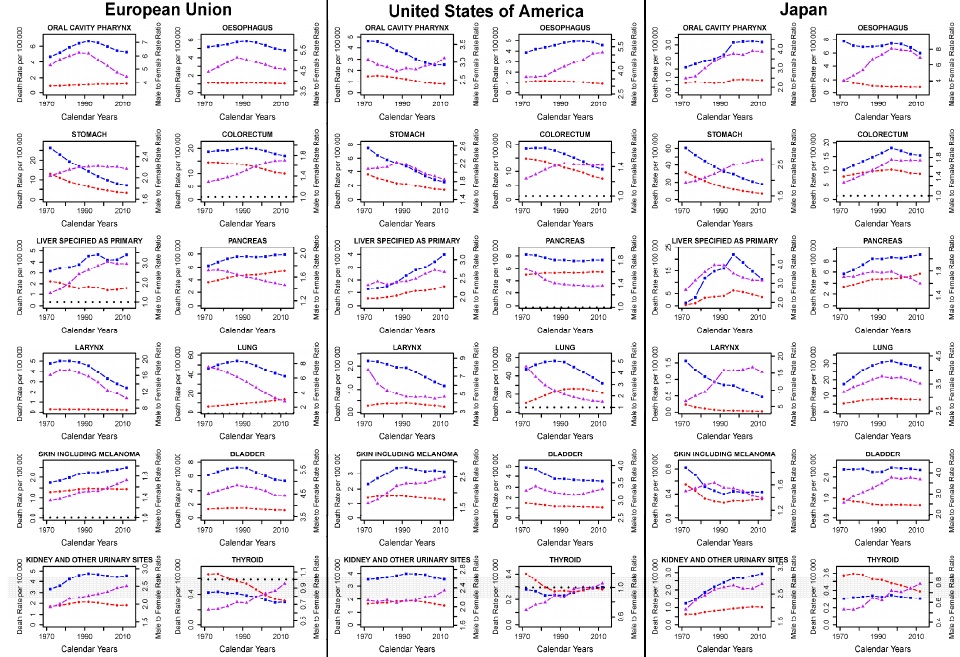
Figure 1. Quinquennial age-standardised mortality rates (blue squares for males, red circles for females) on the left Y-axis, and male-to-female age-standardised sex ratio (purple triangles) on the right Y-axis for major epithelial cancers in the European Union (EU), USA, and Japan, 1970–2014.